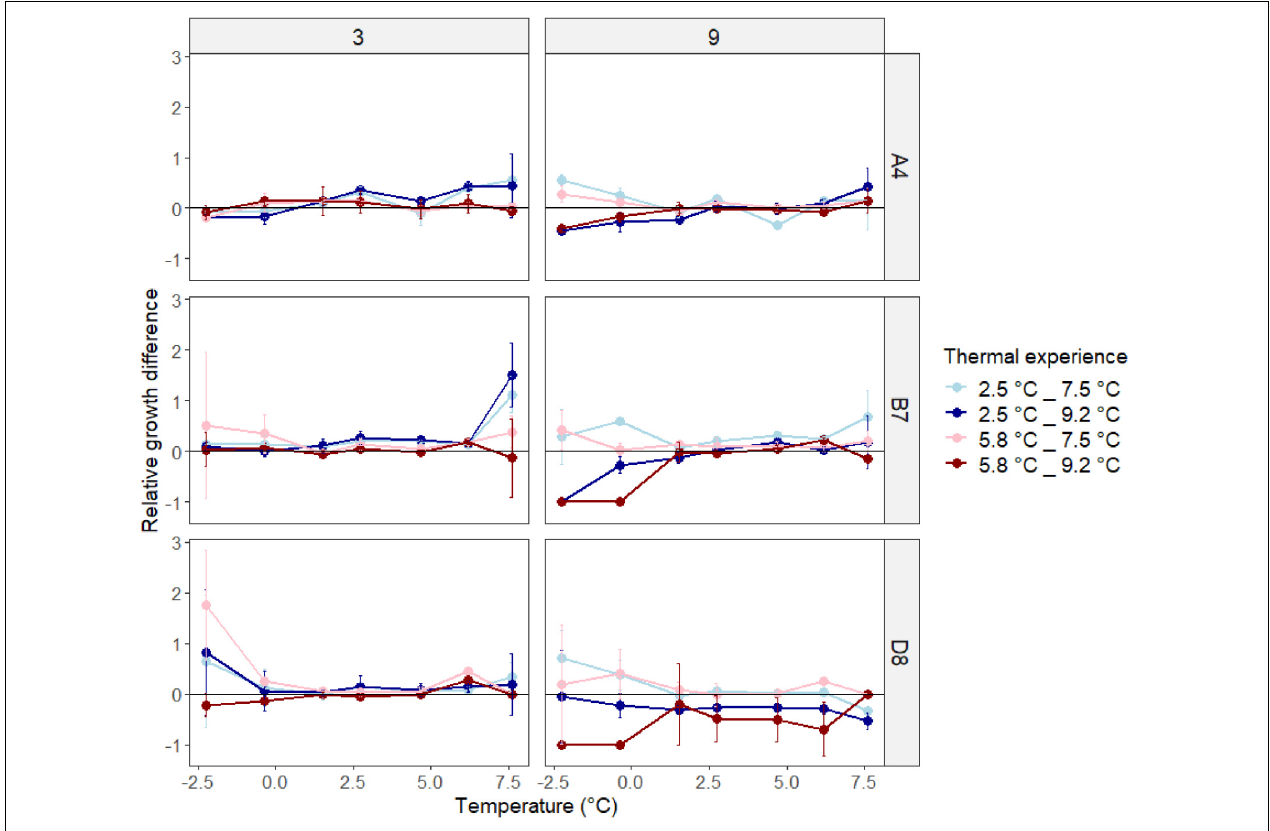
FIGURE 4 | Relative growth difference of experimental populations grown at seven temperatures after exposure to 3 or 9 days heatwaves compared to non-exposed experimental populations, for each genotype. Data represent average values across three replicates ± one standard